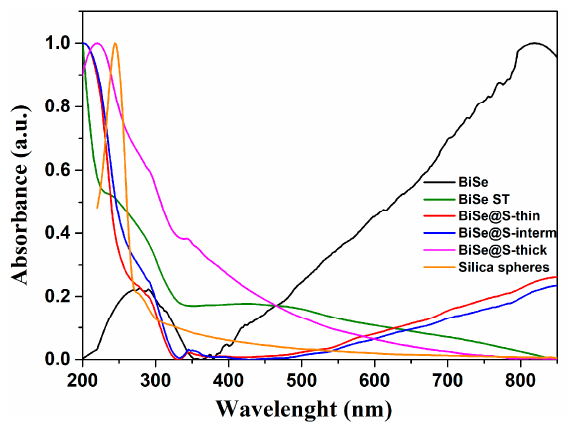
Figure 3. Normalized UV-Vis absorption spectra of the silica-coated nanoparticles with the thin ( ≈ 2–5 nm), intermediate ( ≈ 50–80 nm), and thick ( ≈ 200 nm) silica layer in comparison with the clean, EG coated nanoparticles, and silica spheres. The measurement was done on a suspension with a concentration of 0.1 g/L.